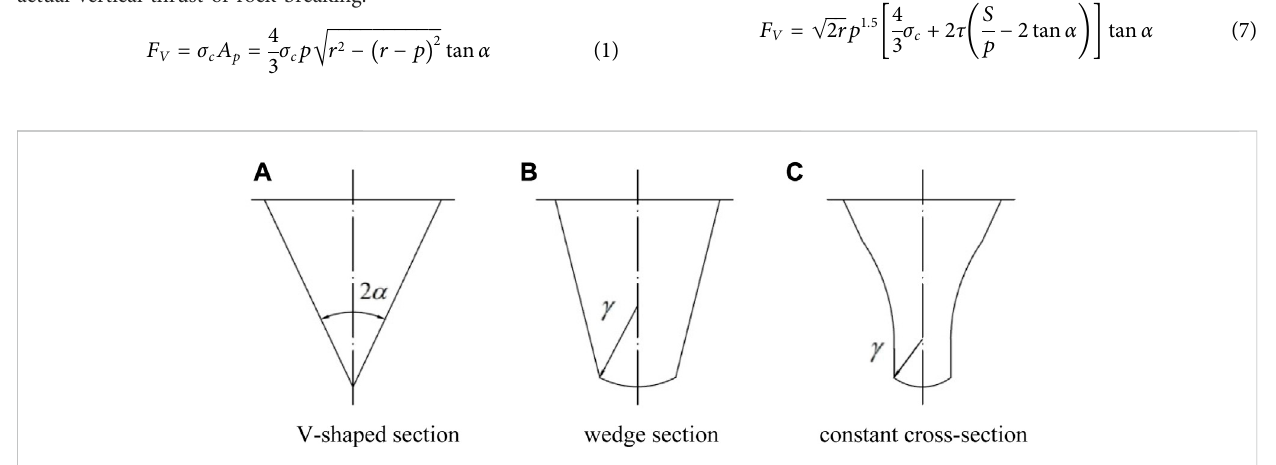
FIGURE 4 The cross-sectional forms of the disc cutter ring (A) V-shaped section (B) wedge section (C) constant cross-section.